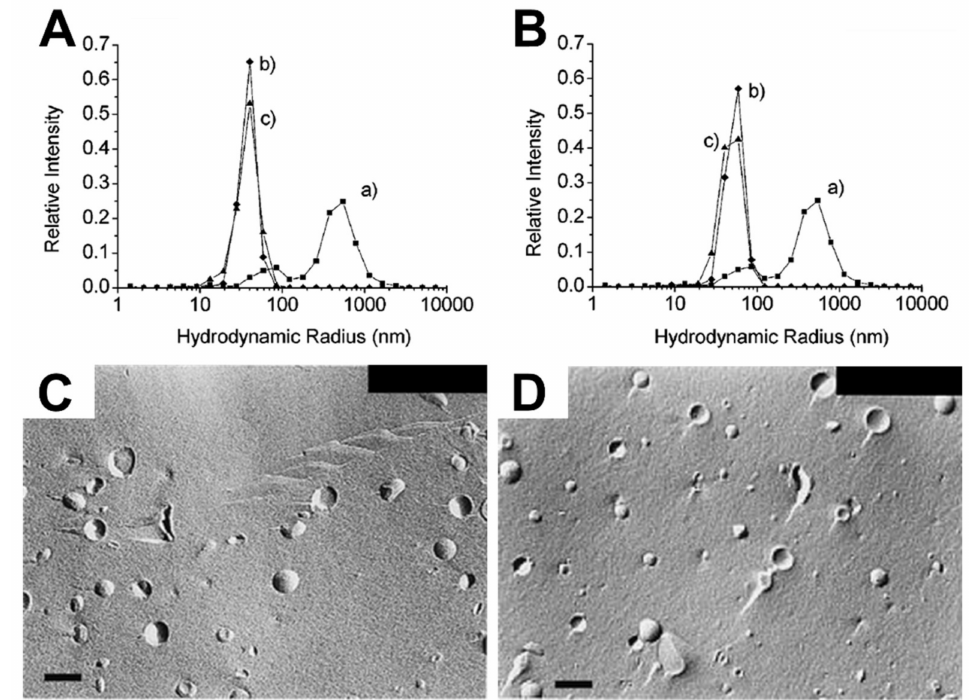
Figure 4. DLS measurements and complementary freeze-fracture electron micrographs measuring the interaction of fatty acids with SUVs and LUVs. DLS-measured size distribution curves of POPC lipid vesicle extruded with ( A ) 50 nm, ( B ) 100 nm diameter pore filters before (curve b) and after (curve c) oleate addition, and freeze-fracture micrographs of ( C ) preformed 180-nm diameter Egg PC vesicles and ( D ) Egg PC/oleate (1:1) vesicles. The scale bars are 200 nm. Reproduced with permission from [36] (Copyright 2003, American Chemical Society) and